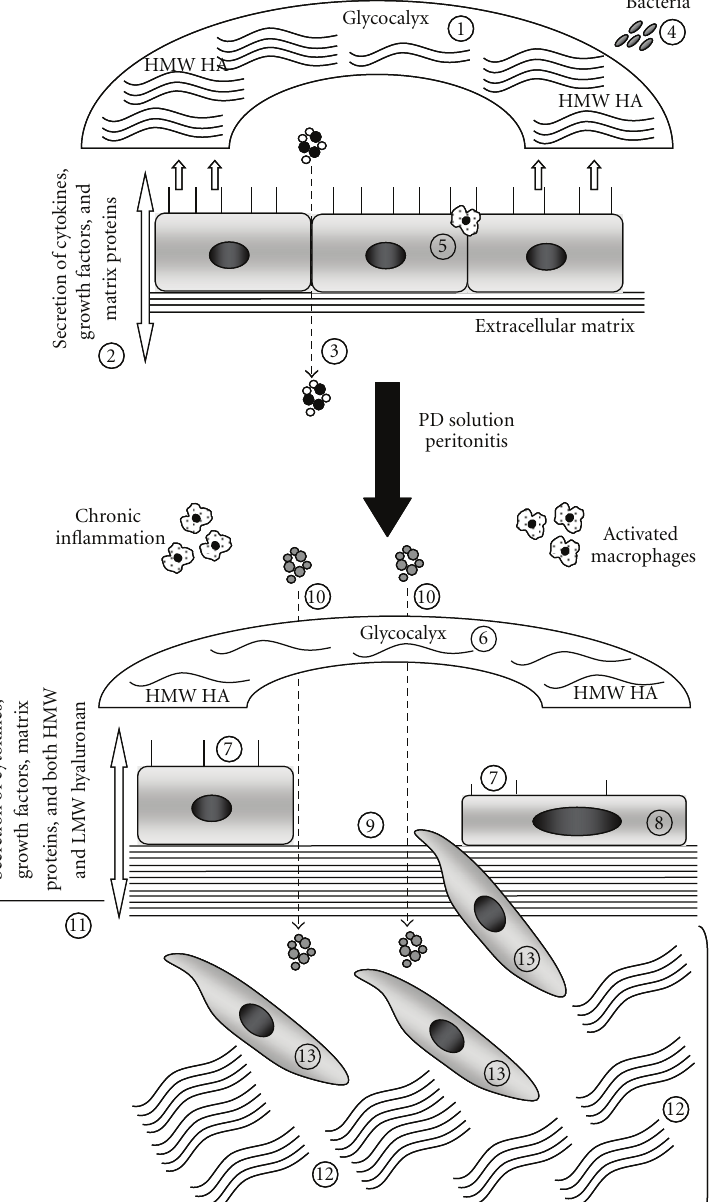
Figure 1: Changes to hyaluronan synthesis during PD alter mesothelial cell functions. The mesothelium contributes to peritoneal homeostasis. Under physiologic conditions, mesothelial cells secrete HMW hyaluronan which is the main constituent of the glycocalyx. The glycocalyx surrounds the apical surface of mesothelial cells and provides a protective barrier against abrasion, and a slippery, nonadhesion surface for intracoelomic movement (1). Mesothelial cells participate in tissue repair and in the induction and resolution of peritoneal inflammation through their ability to synthesize cytokines and growth factors that are secreted into the peritoneal cavity (2). Mesothelial cells also synthesize matrix proteins which provide a substratum onto which mesothelial cells adhere (2). Mesothelial cells facilitate the transport of fluids and solutes across the peritoneal membrane (3), are the first line of defense against bacterial peritonitis (4), and can maintain a chemotactic gradient to assist in leukocyte infiltration (5) during bacterial, chemical, or surgical insult. Changes to the peritoneum following the initiation of PD. Constant exposure of the peritoneal membrane to bioincompatible PD solution results in either a reduction of the glycocalyx volume (6) or its complete depletion from the surface of mesothelial cells. Changes in the content of hyaluronan in the peritoneum can induce morphologic and phenotypic changes to mesothelial cells that include reduced length and density of microvilli on the surface of mesothelial cells (7), generation of senescent cells (8), and frequent denudation of the mesothelium (9), thereby allowing PD solutions to leak into the submesothelium causing peritoneal injury (10). Activation of both immune cells and mesothelial cells further increases synthesis of cytokines and growth factors (11), which exacerbates peritoneal inflammation, fibrogenesis, and increases submesothelial expression of HMW hyaluronan (12). Activation of mesothelial cells induces EMT (13), breakdown of the basement membrane, and their migration into the submesothelium. Communication of activated mesothelial cells with peritoneal fibroblasts and endothelial cells may provoke further inflammatory and fibrotic processes in the submesothelium resulting ultimately in peritoneal